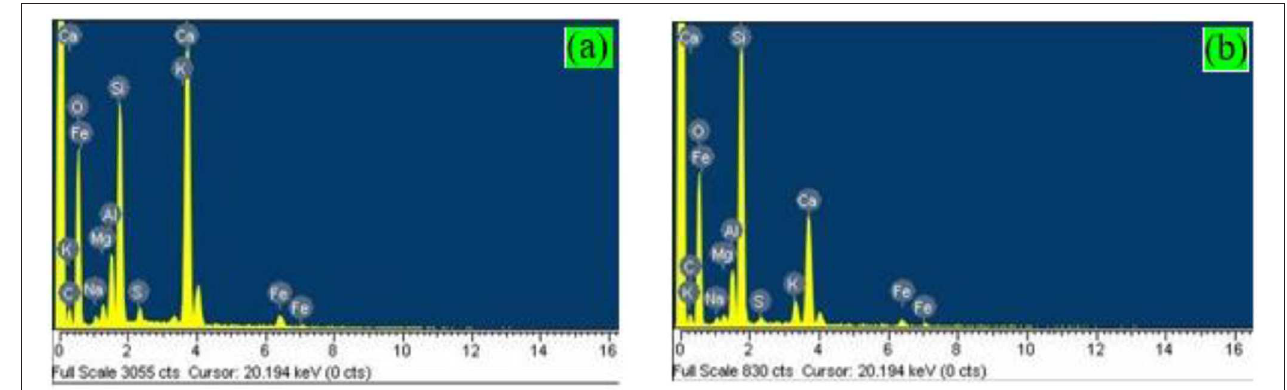
FIGURE 15 | Comparison of EDX spectrum between (a) Control mortar, and (b) Mortar containing